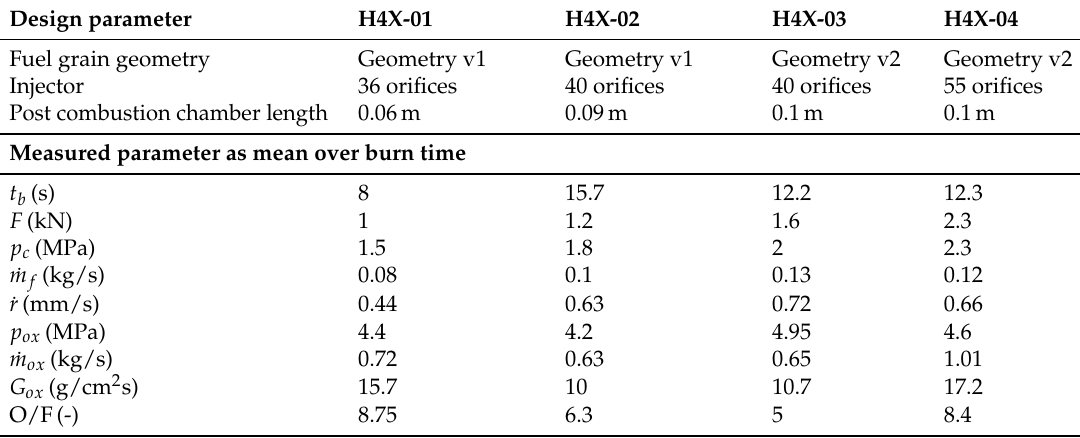
Table 5. Overview of the design and measured parameters of HYDRA 4X-01 to HYDRA 4X-04. Design